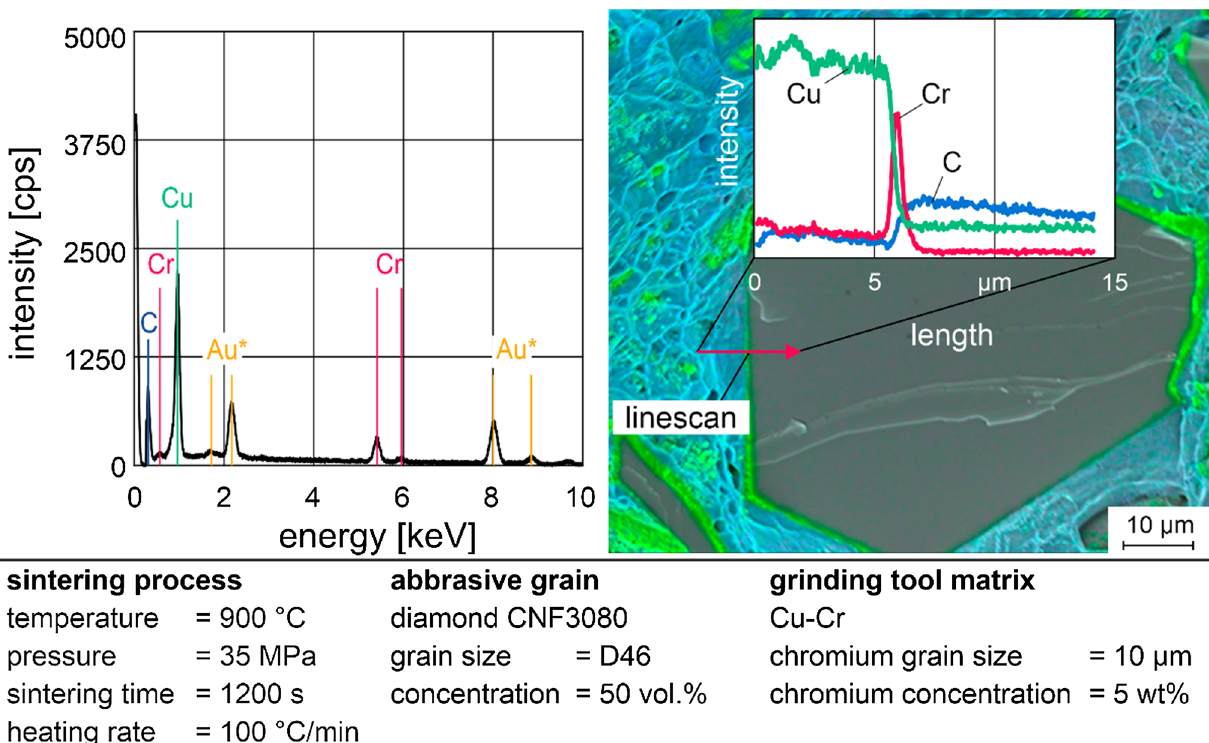
broken diamond grain (grey) surrounded by an approximated 1 µm thick chromium layer (green) and the copper-chromium matrix